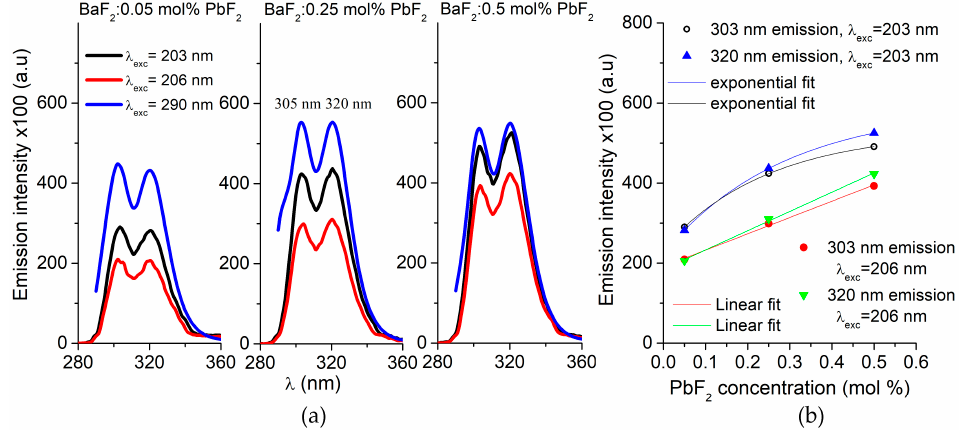
Figure 10. ( a ) Influence of the excitation wavelengths, λ exc = 203, 206, 290 nm, on emission intensity for three PbF 2 concentrations; ( b ) dependence of the emission intensity on the PbF 2 concentration for two excitation wavelengths, λ exc = 203, 206 nm.